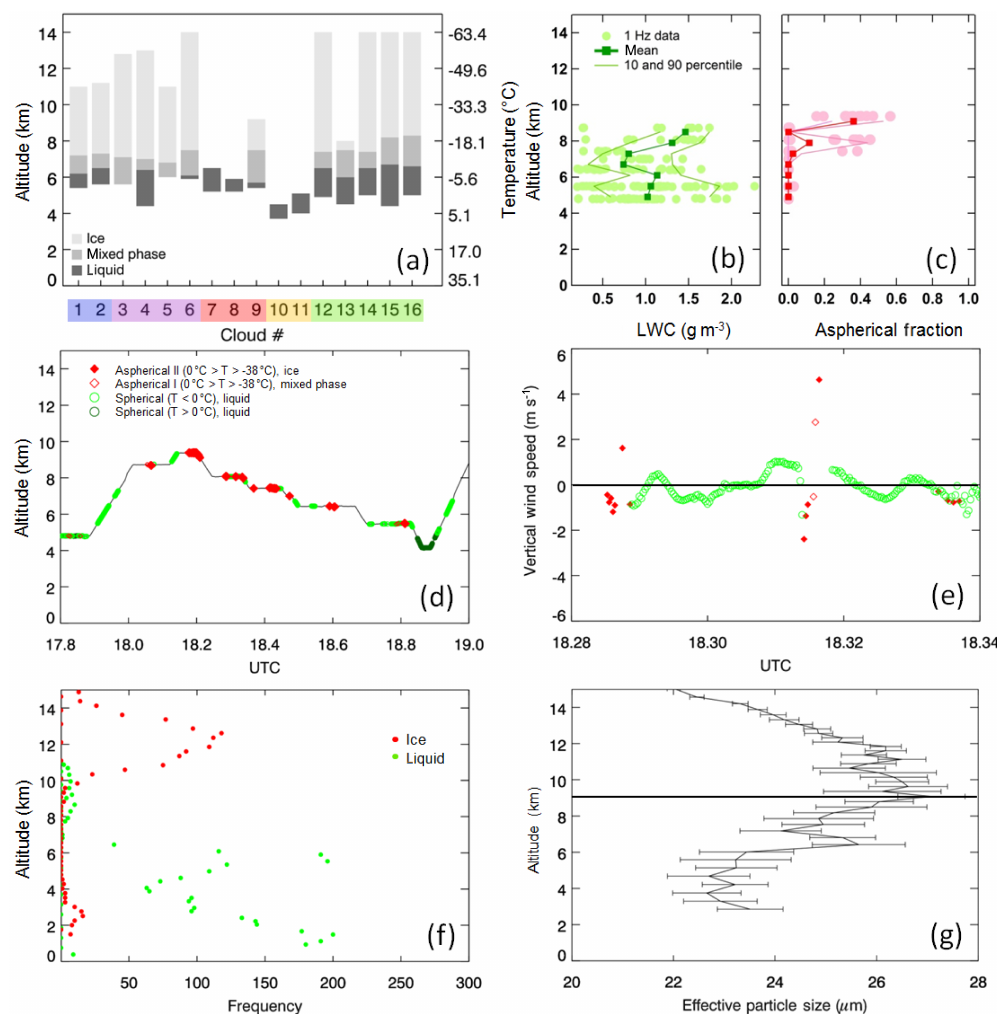
Figure 9. (a) Phase classification of studied clouds based on specMACS observations during flight AC13. (b) Profile of LWC measured with the hotwire probe between 17:50 and 19:00UTC. (c) Aspherical fraction derived from CAS-DPOL in situ data. (d) NIXE-CAPS in situ measurements of liquid, mixed phase, and ice (see Table 2 for definitions). Note that time is given in decimal hours. (e) Short horizontal flight section in the upper part of the mixed-phase layer showing the relationship of vertical wind speed and classified asphericity of cloud particles. Symbols as in (d) . (f) Classification of cloud phase (ice or liquid) from MODIS observations of cloud tops. (g) Mean profile of effective particle radius from ensemble method based on MODIS retrieval data of cloud-top effective radius. The black horizontal line indicates the level of largest ice